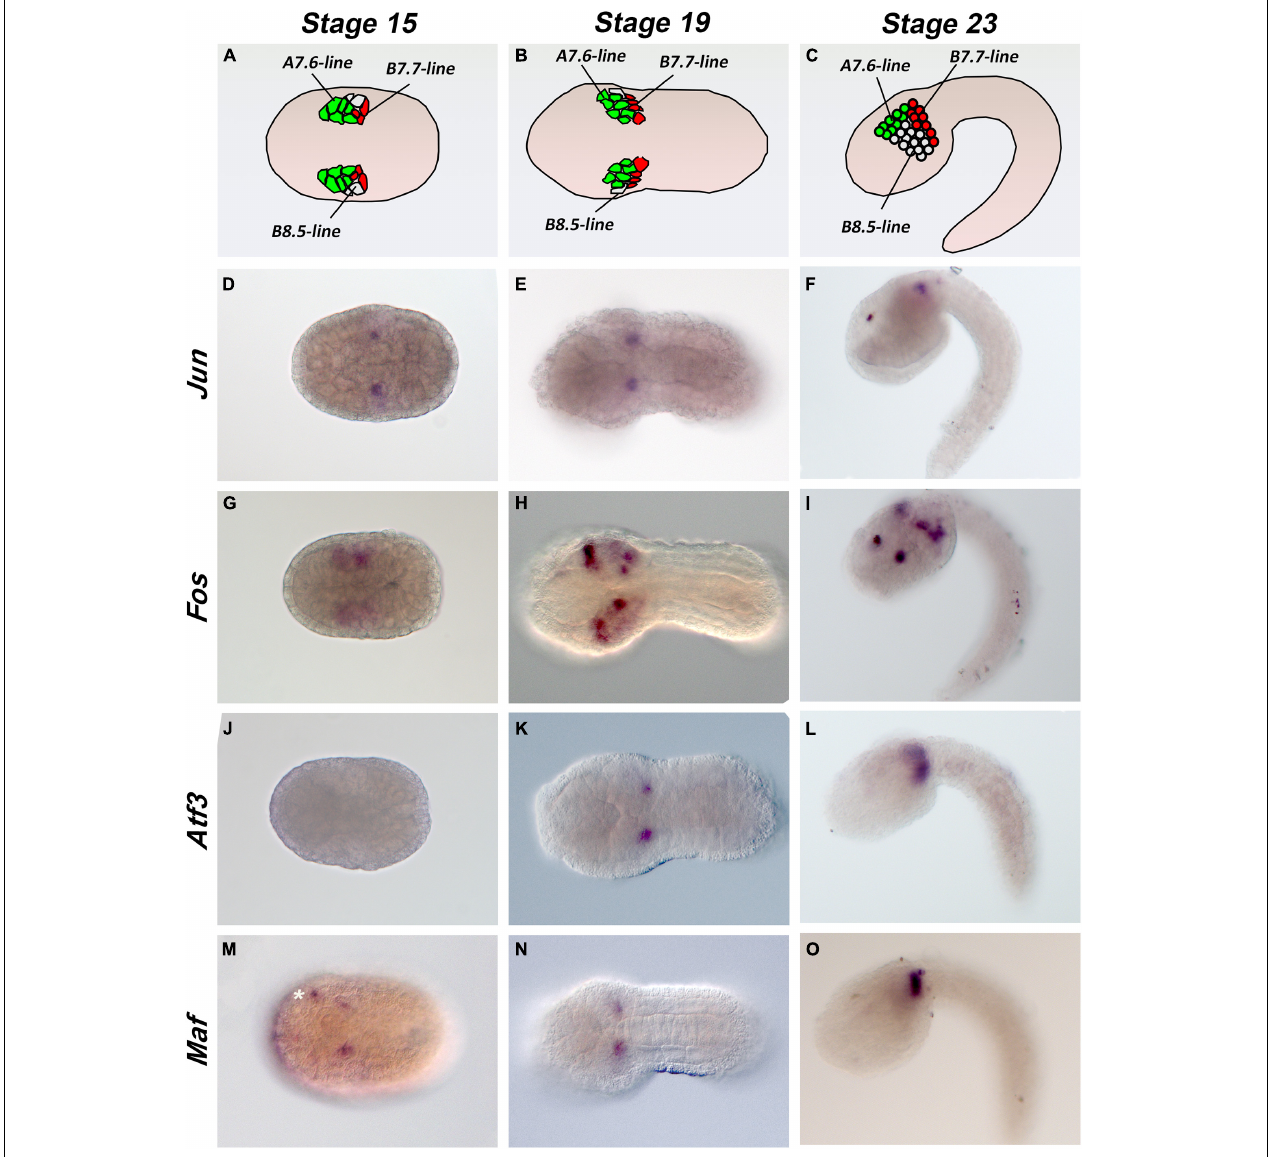
FIGURE 2 | Expression patterns of Ciona AP-1 transcription factors during embryonic development. (A–C) Schematic representation of mesenchymal cells in stage 15, 19, and 23 embryos. (D–O) Whole-mount Ciona embryos hybridized in situ with antisense RNA probes against the Jun (D–F) , Fos (G–I) , Atf3 (J–L) , and Maf (M–O) genes, as indicated on the left side of each row. Developmental stages are indicated at the top of each column: stage 15, early neurula; stage 19, early tailbud I; stage 23, late tailbud I. White asterisk indicates an unspecific signal. Stage 15 and 19 embryos are in a dorsal view, and stage 23 embryos are in a lateral view; anterior is on the